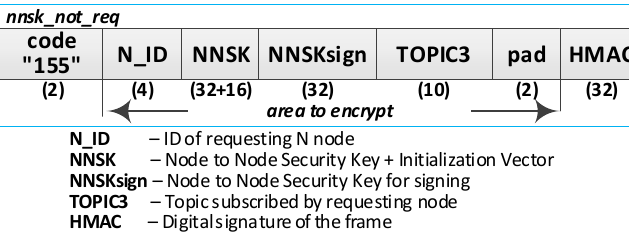
Figure 25. The frame of notification about the new session key.